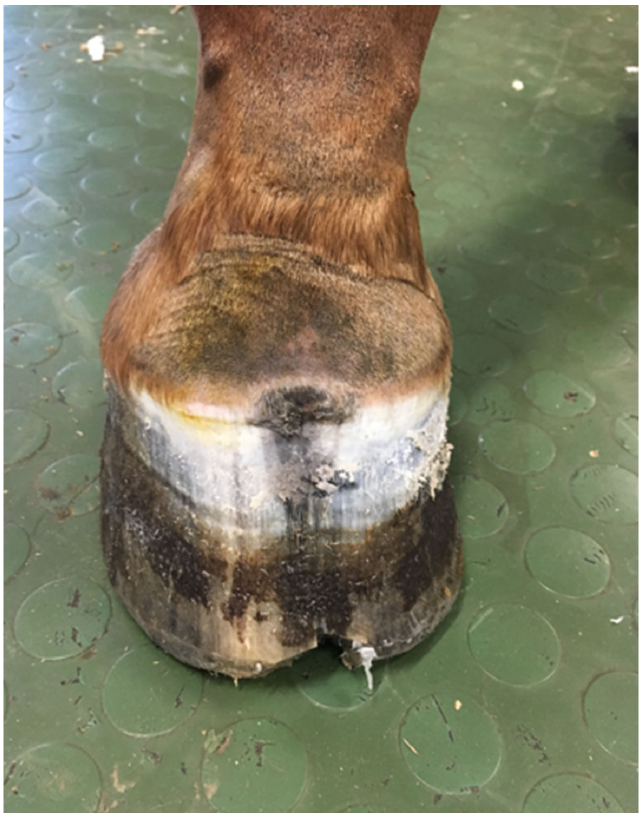
Figure 1. The hoof after superficial cleaning and trimming of the sole, showing visible fistula above the coronary band, deformation, and discoloration of the hoof capsule above at the site of keratoma.